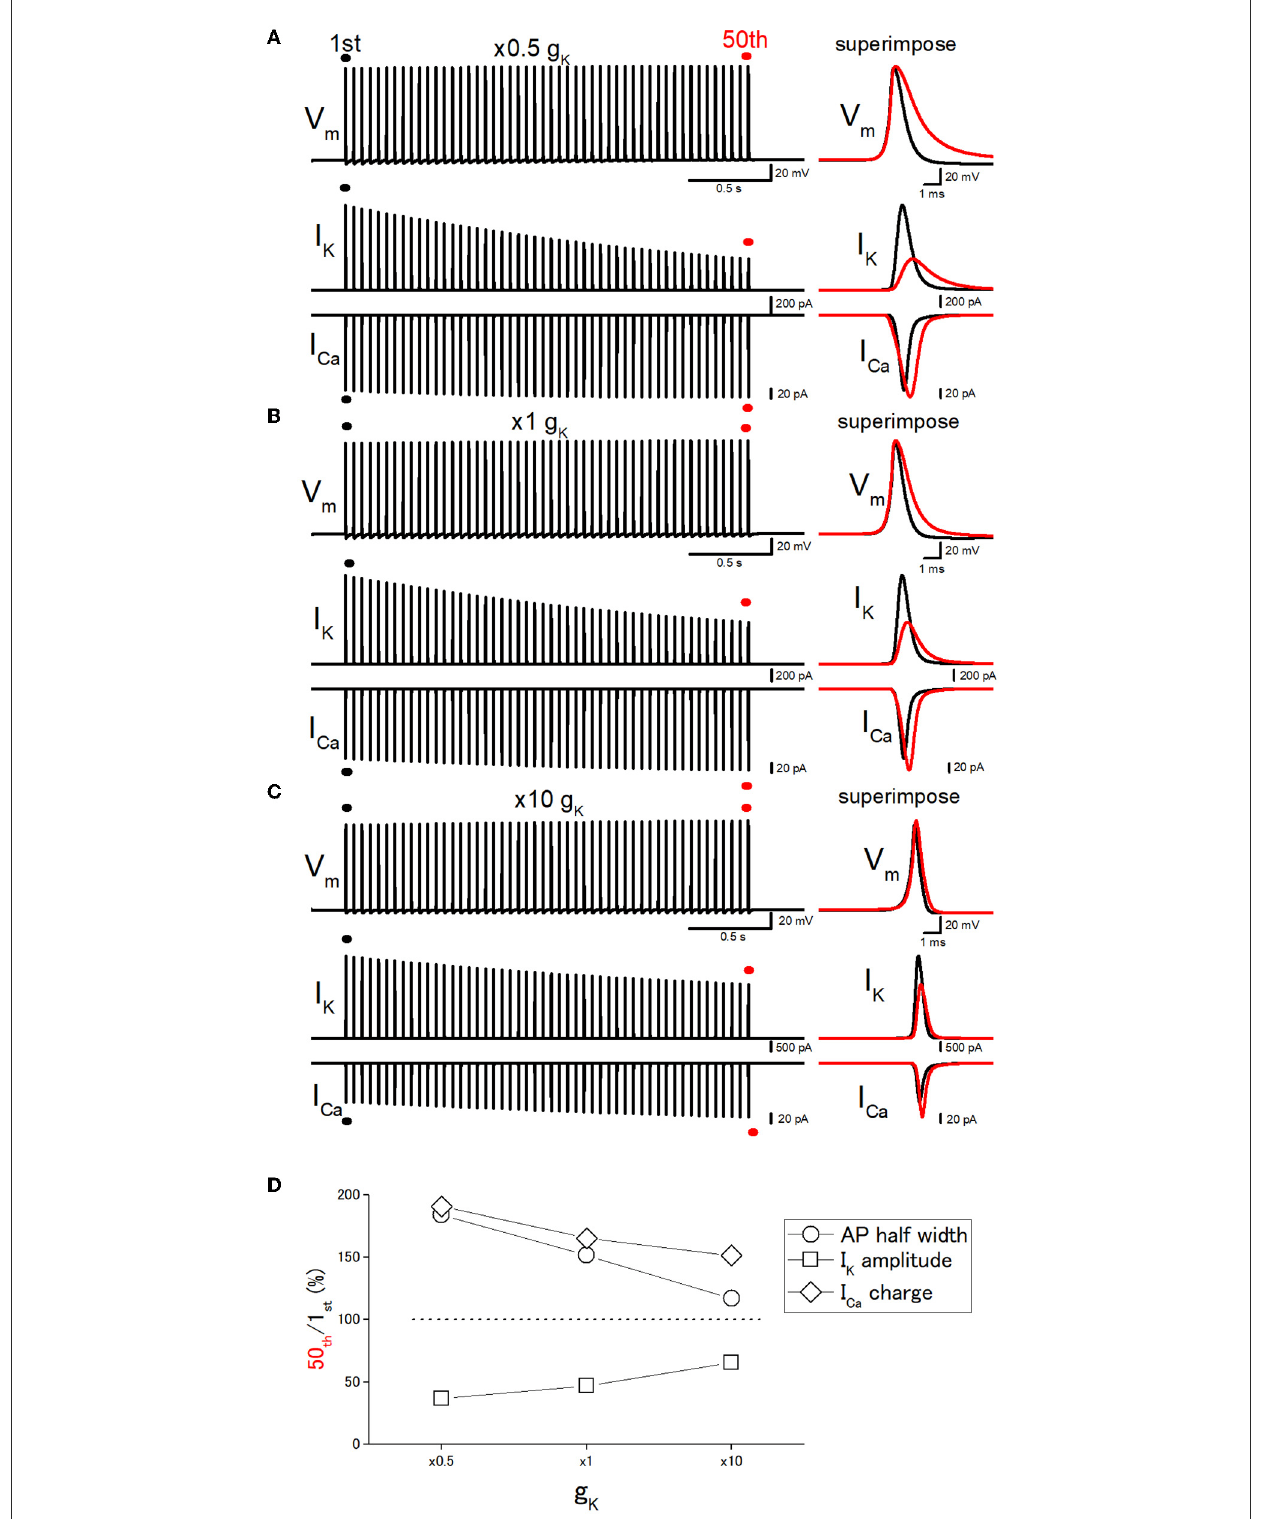
FIGURE5 Effects of changes in the potassium conductance (g K ) on the use-dependent broadening of axonal action potentials. (A) Simulated propagating action potentials at the mossy fiber bouton (V m ), axonal K + current (I K ), and presynaptic Ca 2 + currents (I Ca ) elicited by the repetitive stimuli of 50 times at 20Hz with the models in which the potassium conductance (g K ) was reduced to half ( × 0.5) of the original model. (B) Action potentials simulated with the original ( × 1) g K value. (C) Action potentials simulated with the model in which the g K value was increased to 10 times the original one. In each right panel, the responses to the 50th stimulus (red traces) were superimposed with that elicited by the 1st stimulus (black traces) for comparison. (D) Dose-dependent relationships of the effects of changes in g K values. The relative values of 50th responses/1st responses of the half-width of AP (open circles), the peak amplitude of I K (open squares), and the charge of I Ca (open